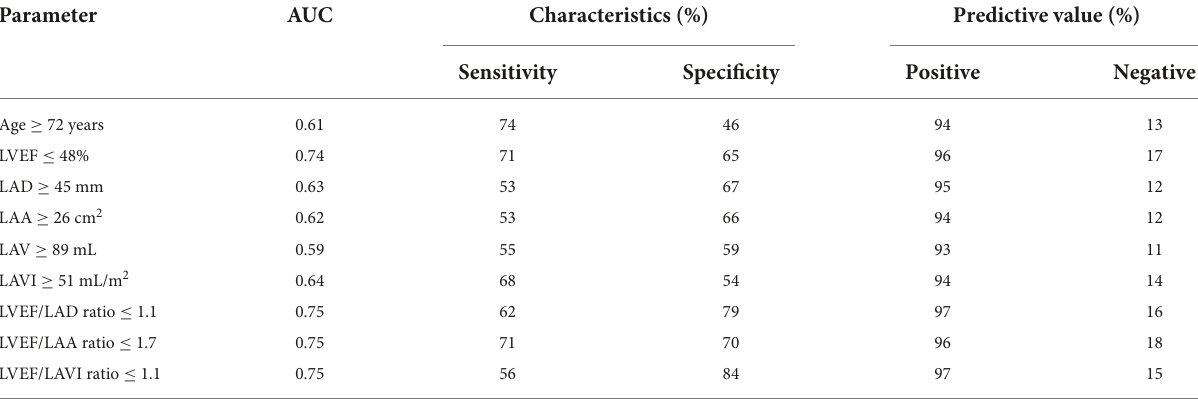
TABLE 3 Accuracy of the pre-specified cut-off values for analyzed parameters as the predictors of